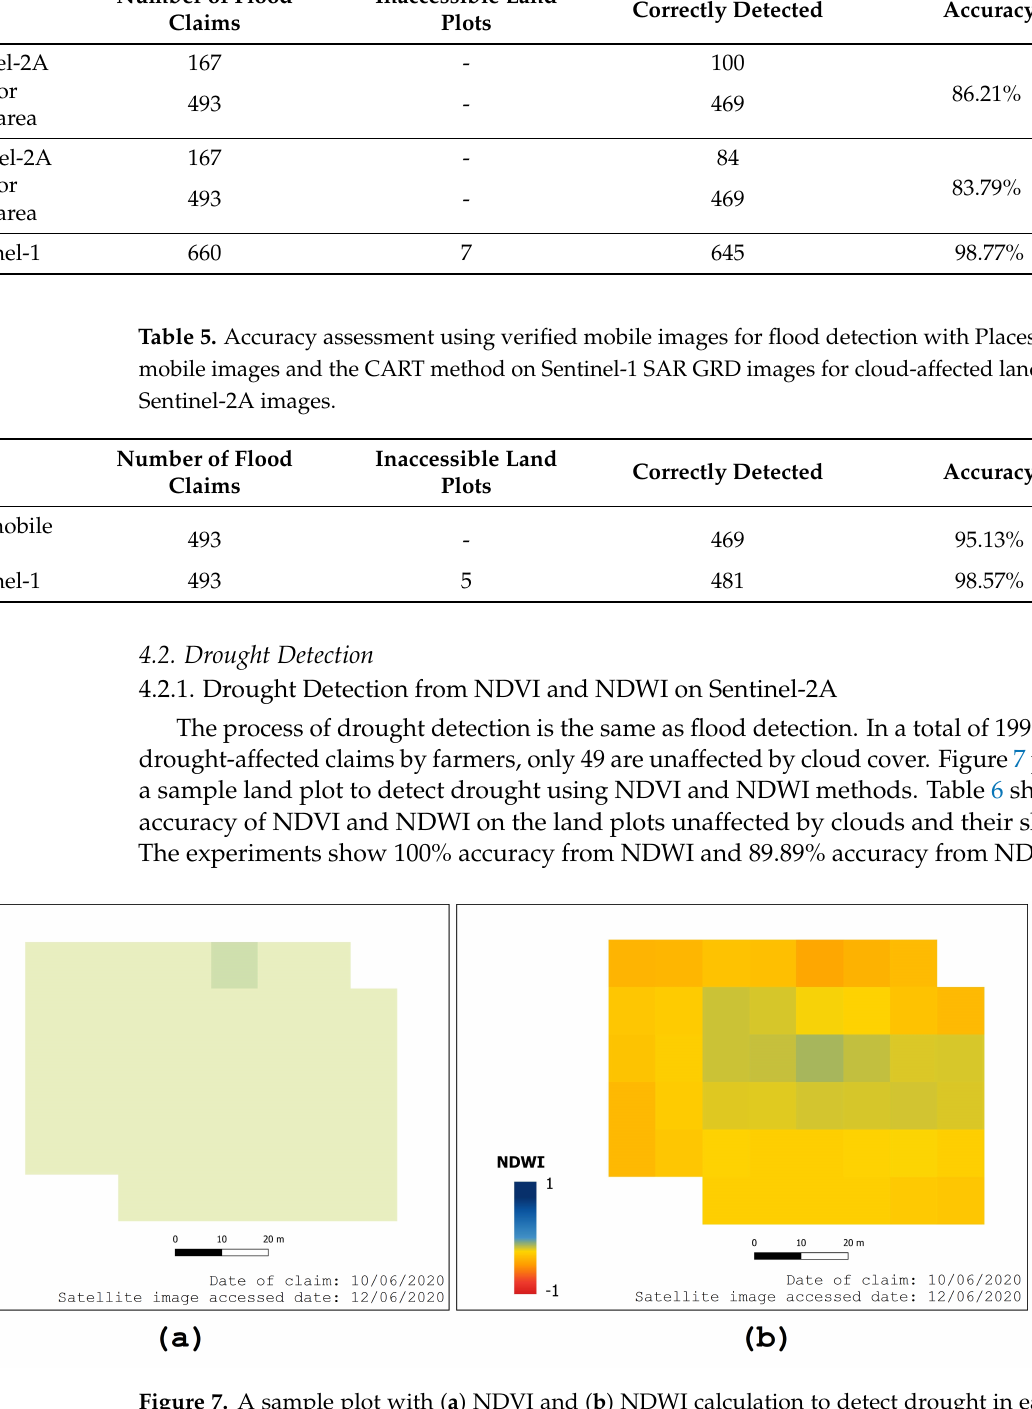
Figure 7. A sample plot with ( a ) NDVI and ( b ) NDWI calculation to detect drought in each pixel obtained from a Sentinel-2A